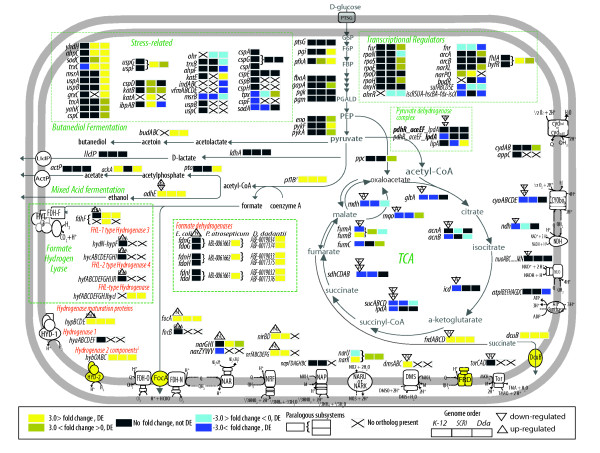
Metabolic overview of conserved pathways in E. coli, P. atrosepticum and D. dadantii. Changes in gene expression under anaerobic conditions are shown for all three organisms and are represented by different colors. Fold change patterns and genome order are as follows: E. coli, P. atrosepticum and D. dadantii (see key within the figure). Each orthologous group of genes is represented by three blocks colored by fold change (dark blue: down-regulated, fold change > 3; light blue: down-regulated, fold change < 3; bright yellow: up-regulated, fold change > 3; dirty yellow: up-regulated, fold change < 3; black: no change in expression, X: ortholog absent in that organism). Fold change values for poly-cistronic operons are averaged across genes. The transcriptional regulators FNR, ArcA, NarP, NarL and FhlA, for which there are known targets, are denoted in the figure based on their mode of regulation: (▲) up regulated (▼) down-regulated. Several components in this figure, such as fermentation and respiratory chains are adapted from Unden and Dunnwald and Sawers et al. 2004 [34,46]. A more detailed diagram of the genomic structure for formate hydrogen lyase complex and accompanying hydrogenases (HYD 1-4) is shown in Figure 3.